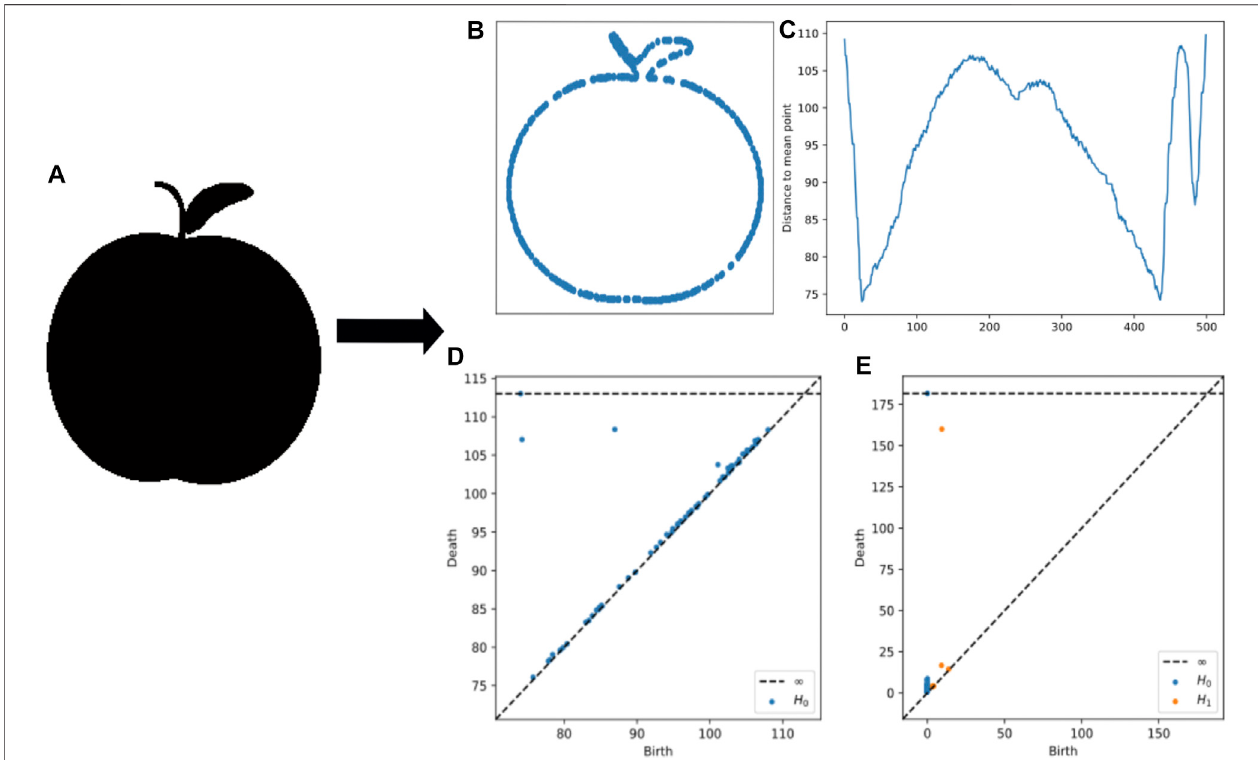
Frontiers in Arti fi cial Intelligence |